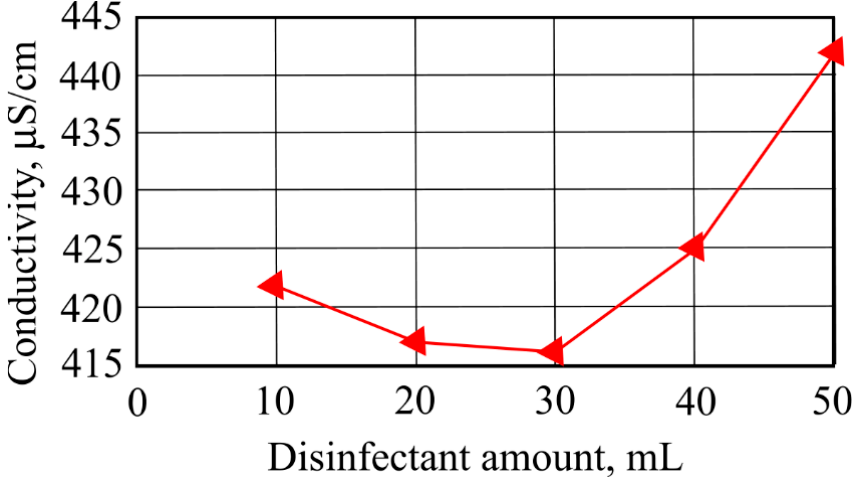
Figure 7. The impact of disinfectants on conductivity.